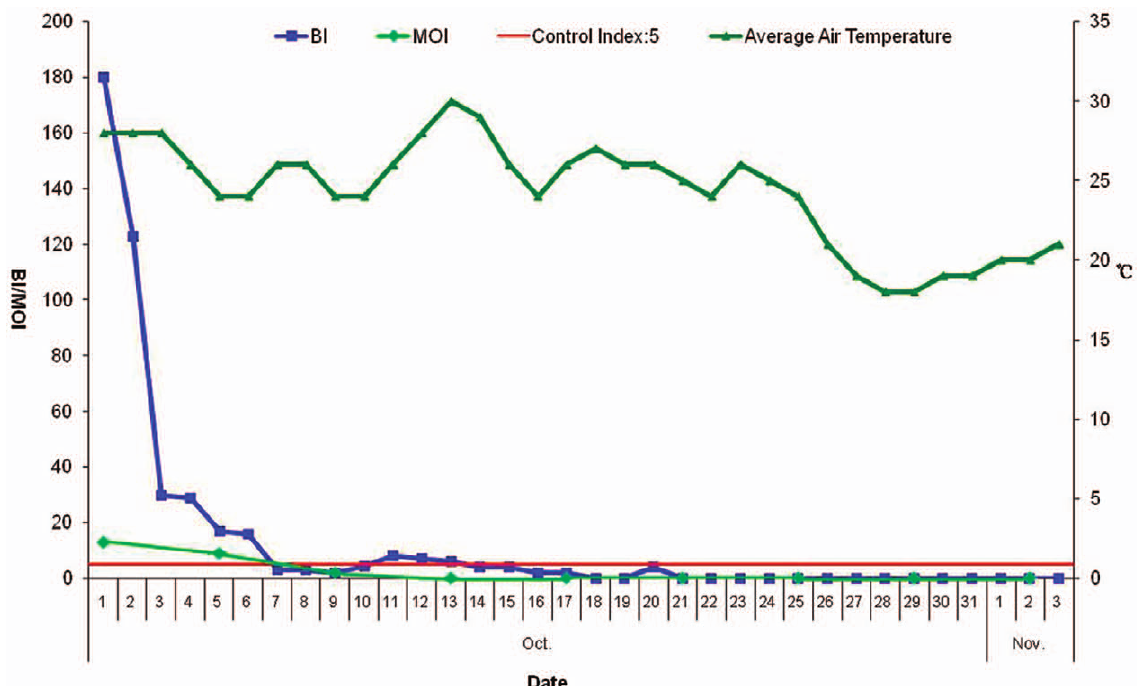
Figure 4. Daily changes in BI, MOI and air temperatures during the CHIK fever outbreak in Xincun.